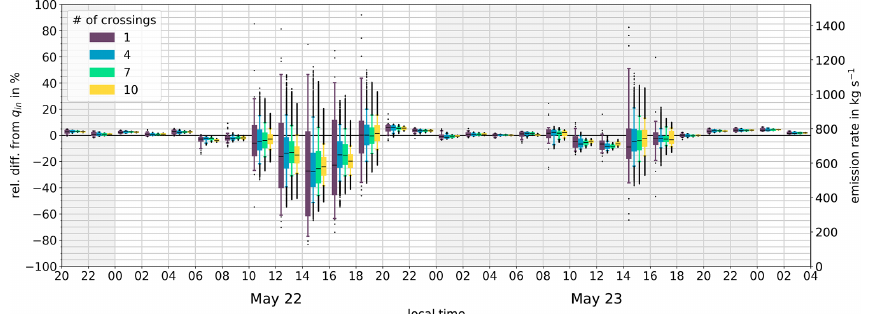
Figure 9. Box–whisker plot of the relative difference to the input emission rate q in within 2h time frames. The right axis shows the associated retrieved emission rates. The width of the distribution decreases with a higher number of crossings. For all time frames it can be stated that with an increasing number of merged crossings, the width of the distribution decreases. The largest differences to q in are observed in the afternoon. Different colors represent a different number of virtual crossings merged for averaging. The inner boxes range from the first to the third quartile, thus containing 50% of the values. The median is marked within as a black dash. The upper whisker is drawn up to the 95th percentile, while the lower whisker is drawn to the 5th percentile. Consequently, 90% of the values are in between the two whiskers. All values outside the whiskers are outliers and plotted as